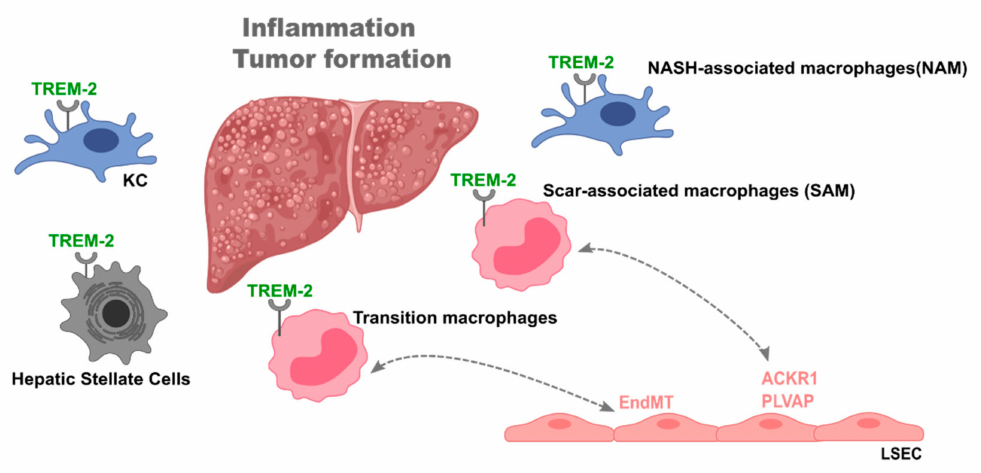
Figure 2. The role of triggering receptor expressed on myeloid cells-2 (Trem-2) in liver disease. Trem-2 plays a fundamental role during liver disease, namely, in non-alcoholic steatohepatitis (NASH), fibrosis, and cirrhosis. Liver Trem-2 expression was shown to control tumor formation and inflammation and being increased in livers of cirrhotic patients. Trem-2 is expressed in different cell types such as Kupffer cells, recruited macrophages, and hepatic stellate cells. In particular, different macrophage populations, i.e., NASH-associated macrophages (NAM), scar-associated macrophages (SAM), and transition macrophages, are characterized by Trem-2 expression and found in specific settings of liver disease. Further, SAM and transition macrophages interact with a particular endothelial cell population expressing atypical chemokine receptor 1 (ACKR1) and plasmalemma vesicle-associated protein (PLVAP) and induce an endothelial to mesenchymal transition, respectively, in the disease setting. This places Trem-2 as plausible mediator of liver macrophage-endothelial cell